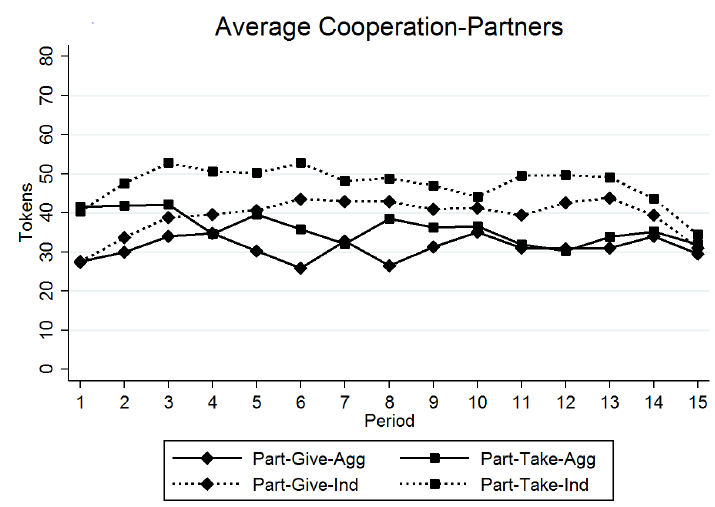
Figure 1. Average Cooperation Over Time (Partners).